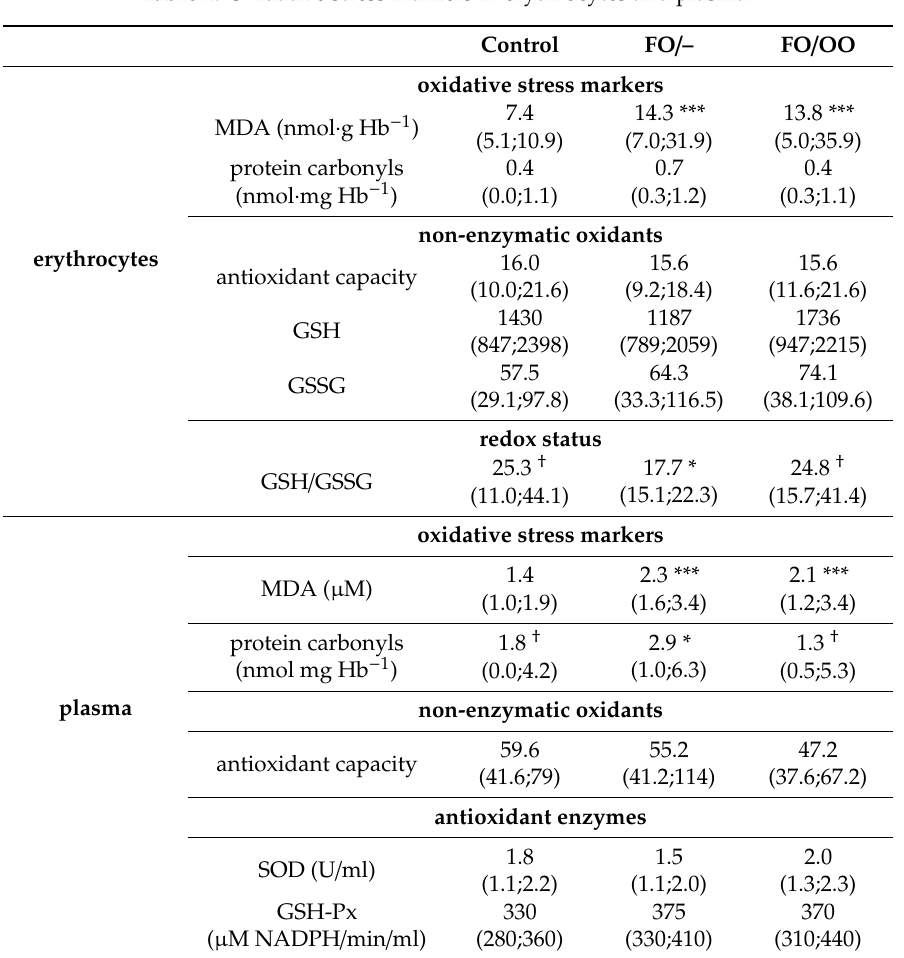
Table 2. Oxidative stress markers in erythrocytes and